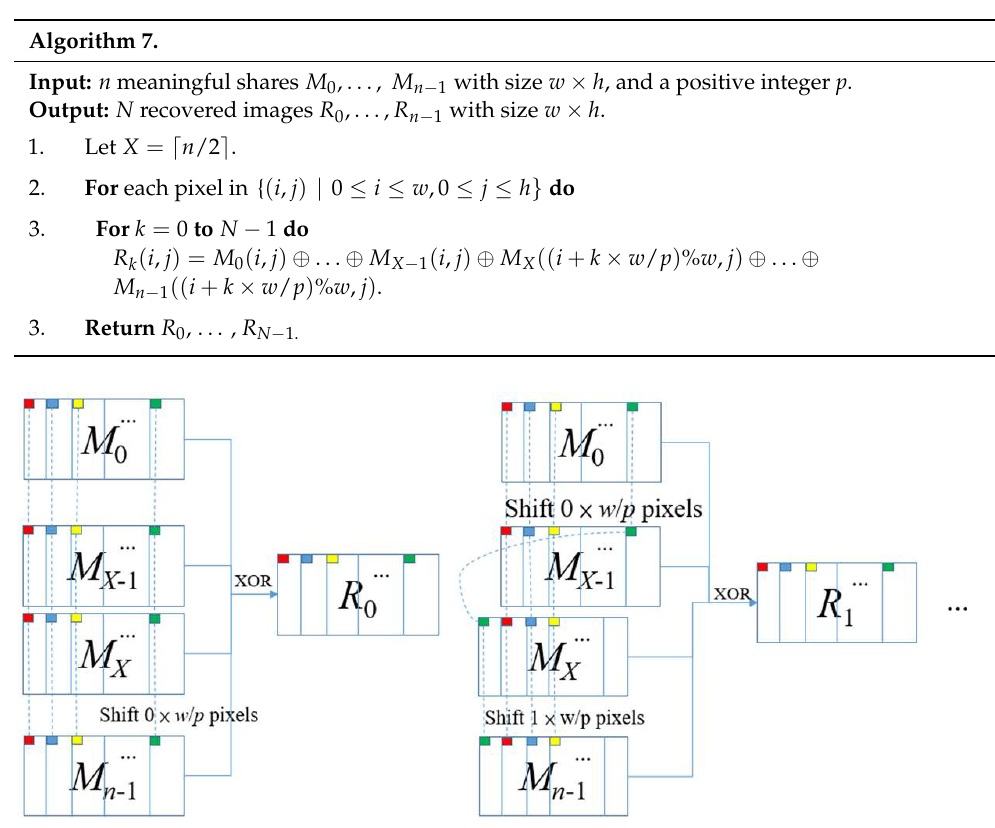
Figure 14. The schematic diagram of Algorithm 7.